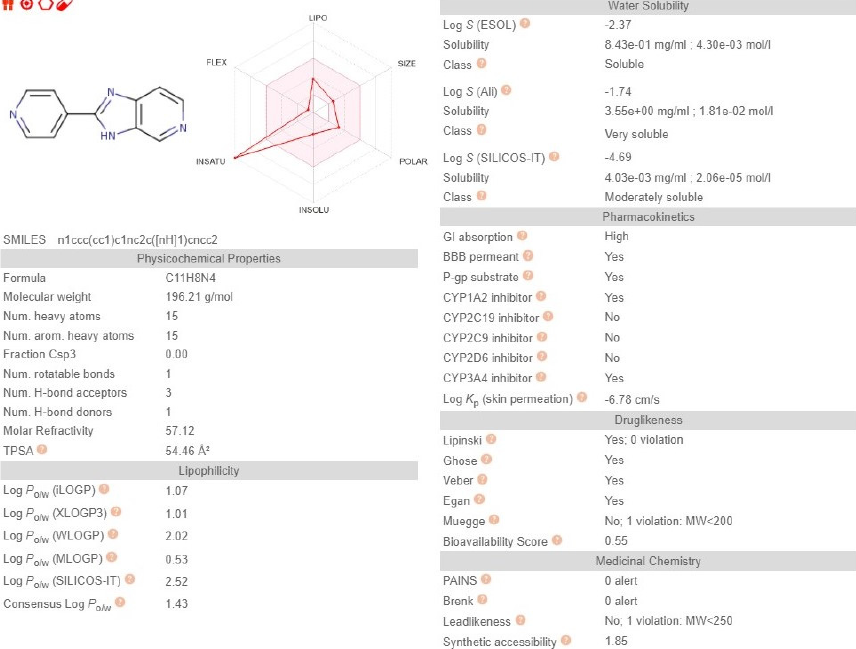
Figure 9. ADME for L2 .